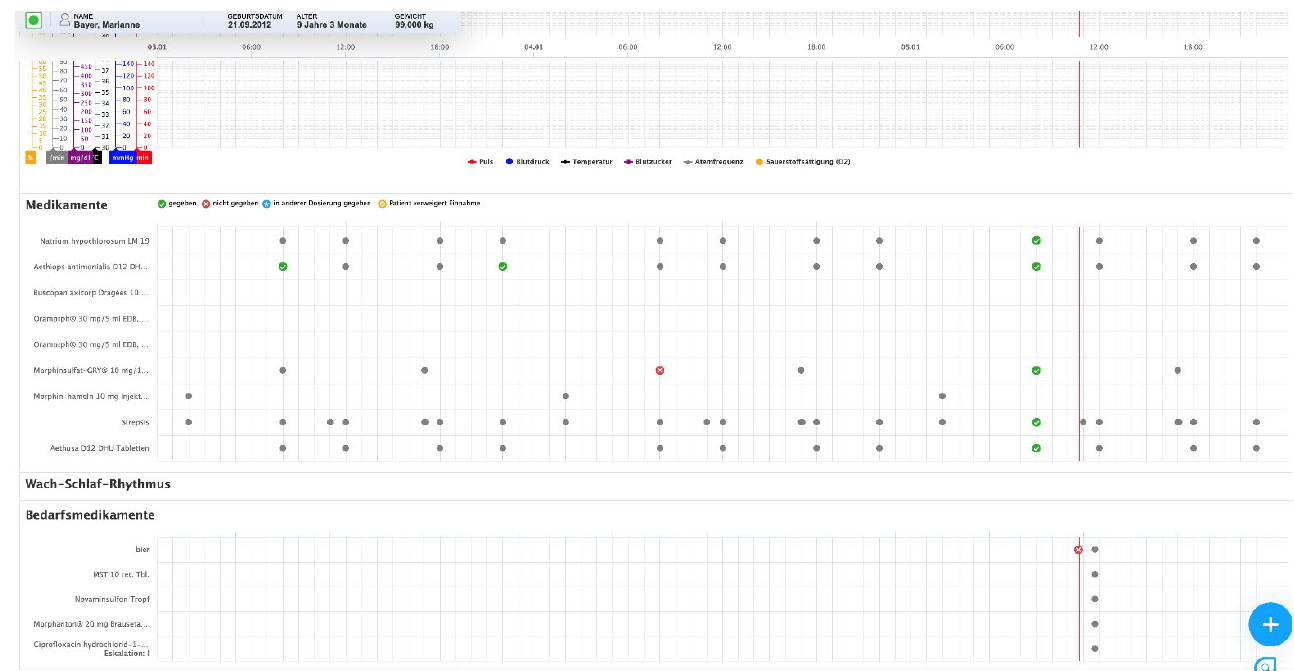
Figure 2. View for the documentation of medications in the patient chart module (ISPC/smart-Q).